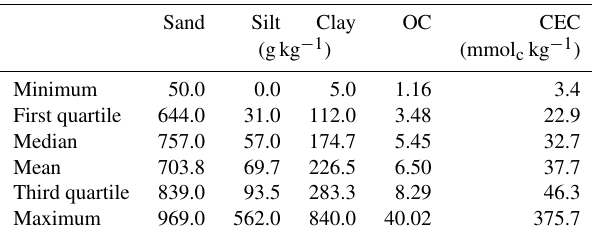
Table 1. Descriptive statistics of the soil properties